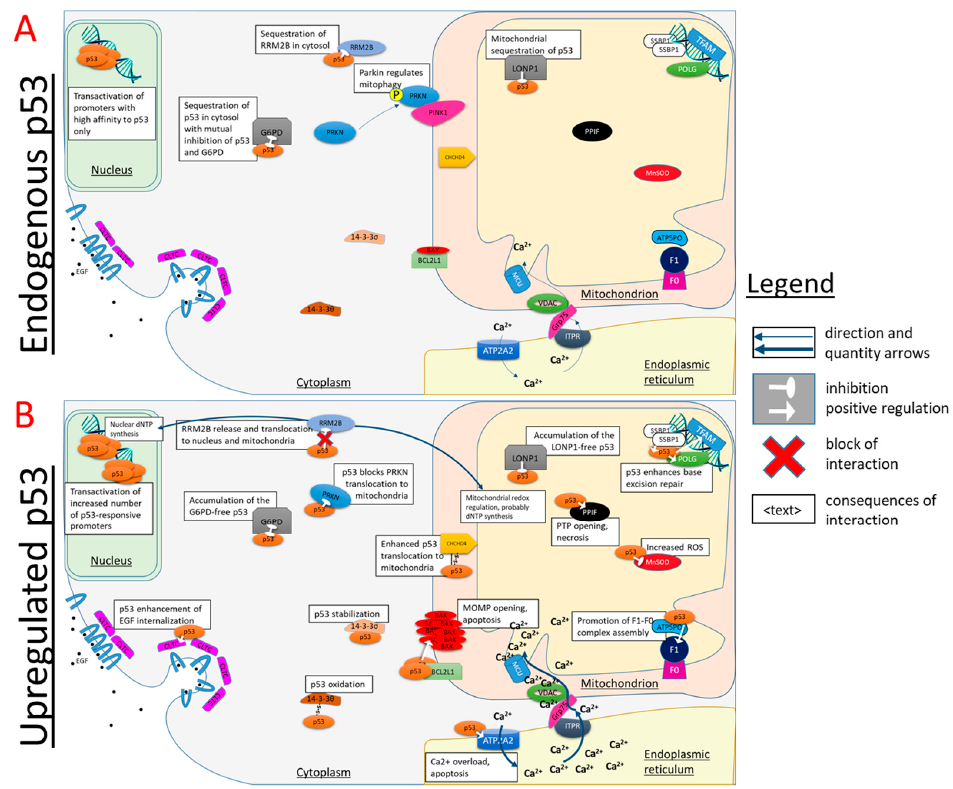
Figure 5. Involvement of non-nuclear protein complexes of p53 in p53-dependent regulation of cellular homeostasis. The complexes formed upon endogenous p53 expression, ( A ) or in case of p53 upregulation during cellular stresses, such as oxidative, cytotoxic or genotoxic ones ( B ), are shown. The names of cellular compartments are underlined. Further explanations are given in the text and Table 1.